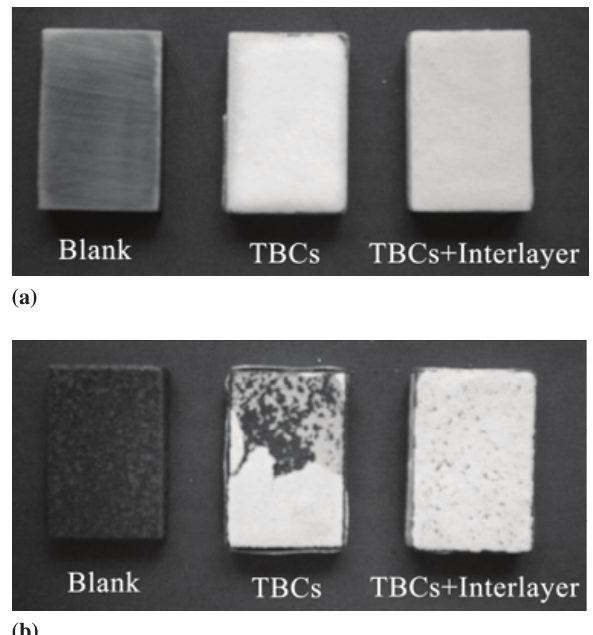
Figure 4. Photographs of specimens with various coat- ings (a) before and (b) after cyclic oxidation at 1000 ı C for 15